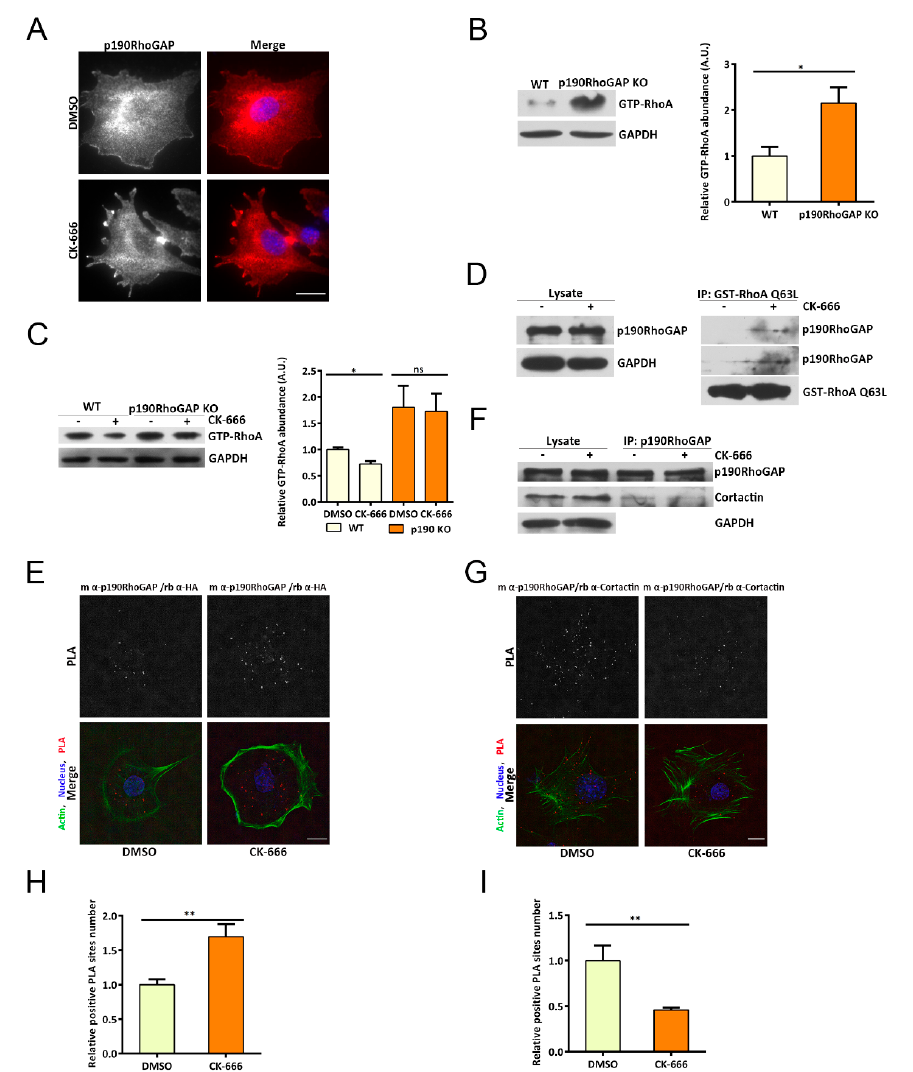
Figure 2. p190RhoGAP is responsible for reduced RhoA activity upon inhibition of the Arp2/3-branched actin. ( A ) Representative immunofluorescent images of p190RhoGAP in MEFs treated with DMSO or CK-666, with red: p190RhoGAP, blue: nucleus, and scale bar of 20 µm. ( B ) Western blot showing GTP-RhoA levels with or without p190RhoGAP: GAPDH was used as loading control, error bar indicates SEM, * p < 0.05, by student’s t test, n = 3 independent experiments. ( C ) Western blot showing GTP-RhoA in wild-type and p190RhoGAP knockout cell lines treated with DMSO or CK-666: GAPDH was used as loading control, error bar indicates SEM, * p < 0.05, ns, no significant difference, by student’s t test, and n = 3 independent experiments. ( D ) Western blot showing p190RhoGAP and GST-RhoA Q63L interaction change after DMSO or CK-666 treatment: GST-RhoA Q63L was used to incubate with total cell lysate and then pulled down by GST-conjugated beads. ( E ) Representative images of the proximity ligation assay (PLA; in situ) between p190RhoGAP and HA-RhoA Q63L: the red staining represents positive PLA sites; scale bar is 20 µm. ( F ) Western blot showing p190RhoGAP and cortactin interaction in cells treated with DMSO or CK-666: Co-IP assay was performed as indicated. ( G ) Representative images of the proximity ligation assay (in situ PLA) between p190RhoGAP and cortactin: the red staining represents positive PLA sites; scale bar is 20 µm. ( H ) Quantification of relative positive PLA sites number for the interaction between p190RhoGAP and RhoA Q63L, the error bar indicates SEM, ** p < 0.05, by student’s t test. ( I ) Quantification of relative positive PLA sites number for the interaction between p190RhoGAP and cortactin, the error bar indicates SEM, ** p < 0.05, by student’s t